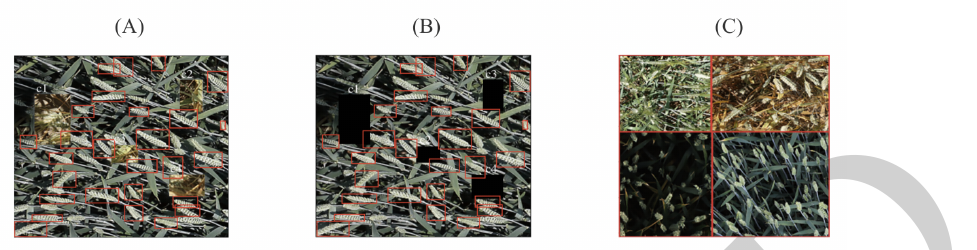
Figure 3. Illustrations of three data enhancement methods. ( A ) Cutout method; ( B ) cutmix method; ( C ) mosaic